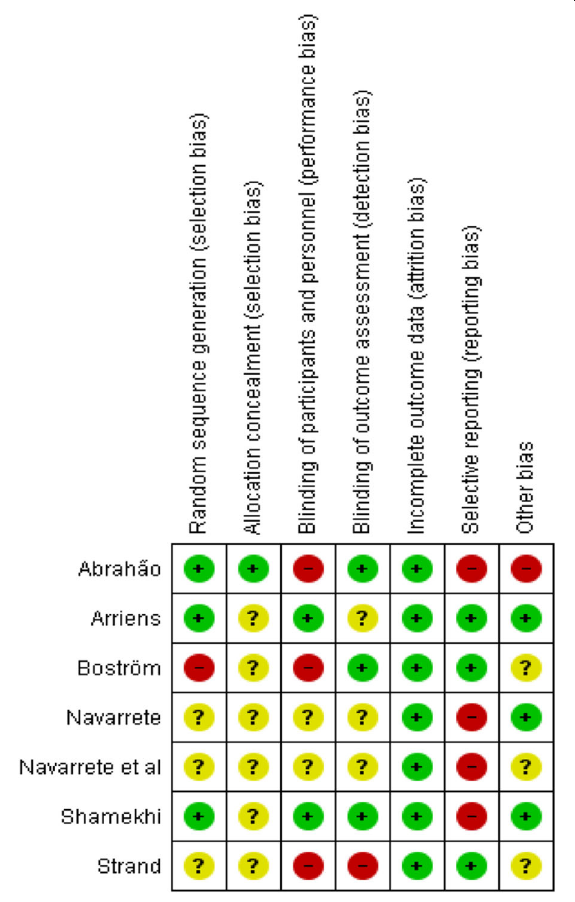
Fig. 2 Review author judgments about the risk for each bias item in all included trials